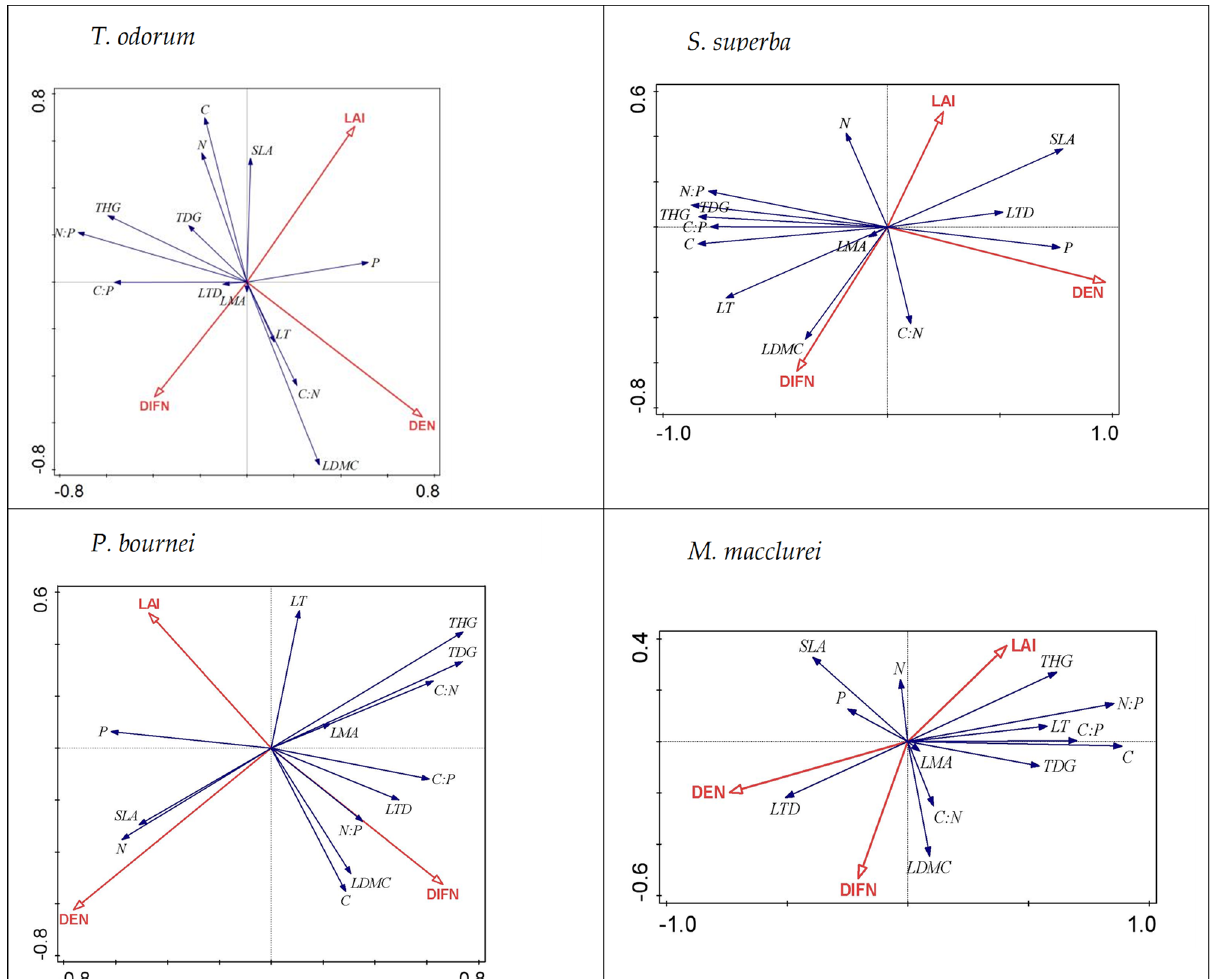
Figure 1. The RDA analysis of growth, leaf functional traits and C,N,P stoichiometry and environ- mental factors. Where LAI, DEN and DIFN stand for leaf area index, tree density and non-intercepted scattering, respectively. HTG, GDG, SLA, LTD, LT, LMA, LDMC represent height growth, ground diameter growth, specific leaf area, leaf tissue density, leaf thickness, leaf mass per unit area, leaf dry matter content.